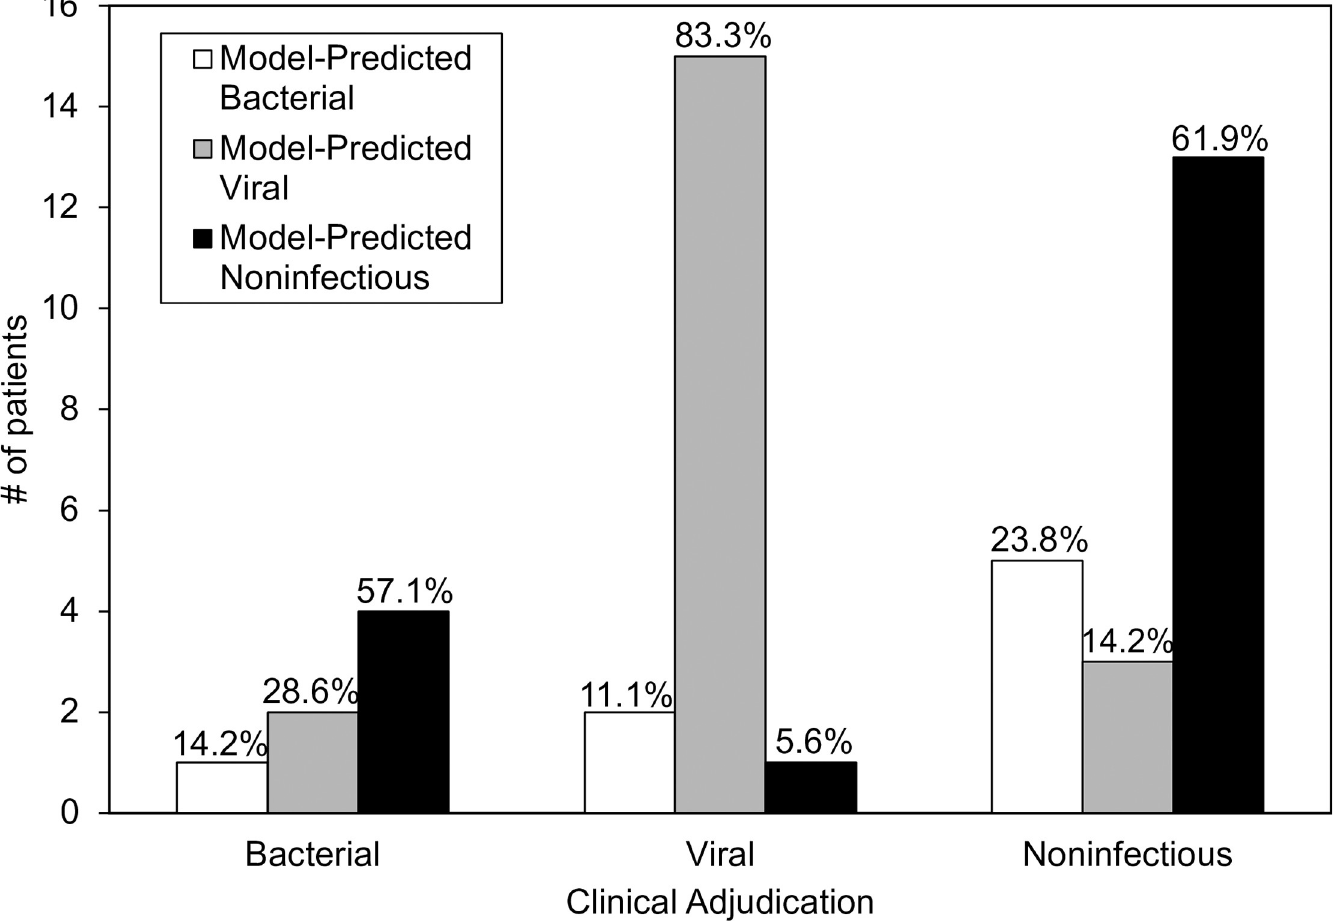
Fig 3. Gene expression classification of the asthma exacerbation cohort. The fixed-weight gene expression model developed in the training cohort was applied to each of the 46 asthma exacerbation cases to determine gene expression-based classification. Clinical adjudication groups were subsequently stratified by gene expression class, with the respective percentages indicated at the top of each bar. Viral and noninfectious groups had a high degree of agreement between adjudication and model classification (83.3% and 61.9%, respectively), but those adjudicated bacterial were often classified as viral or noninfectious by the model.